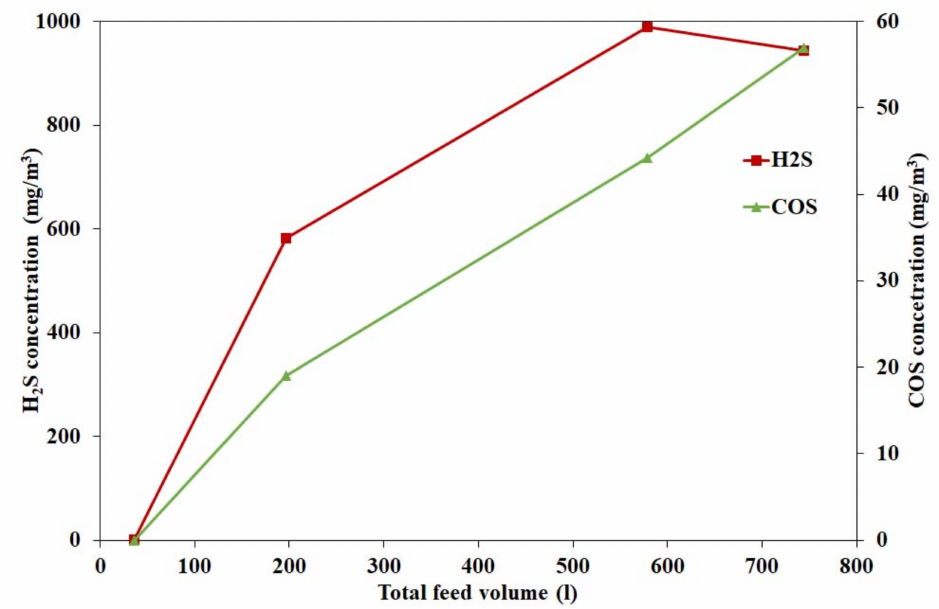
Figure 17. Catalytic tests with feed gas mixture 2 (50 mole% CO, 0.4 mole% H 2 S, balance N 2 ) at pressure 0.5 MPa over a catalyst based on Cu (14.8 wt%). Content of H 2 S and COS in the gas